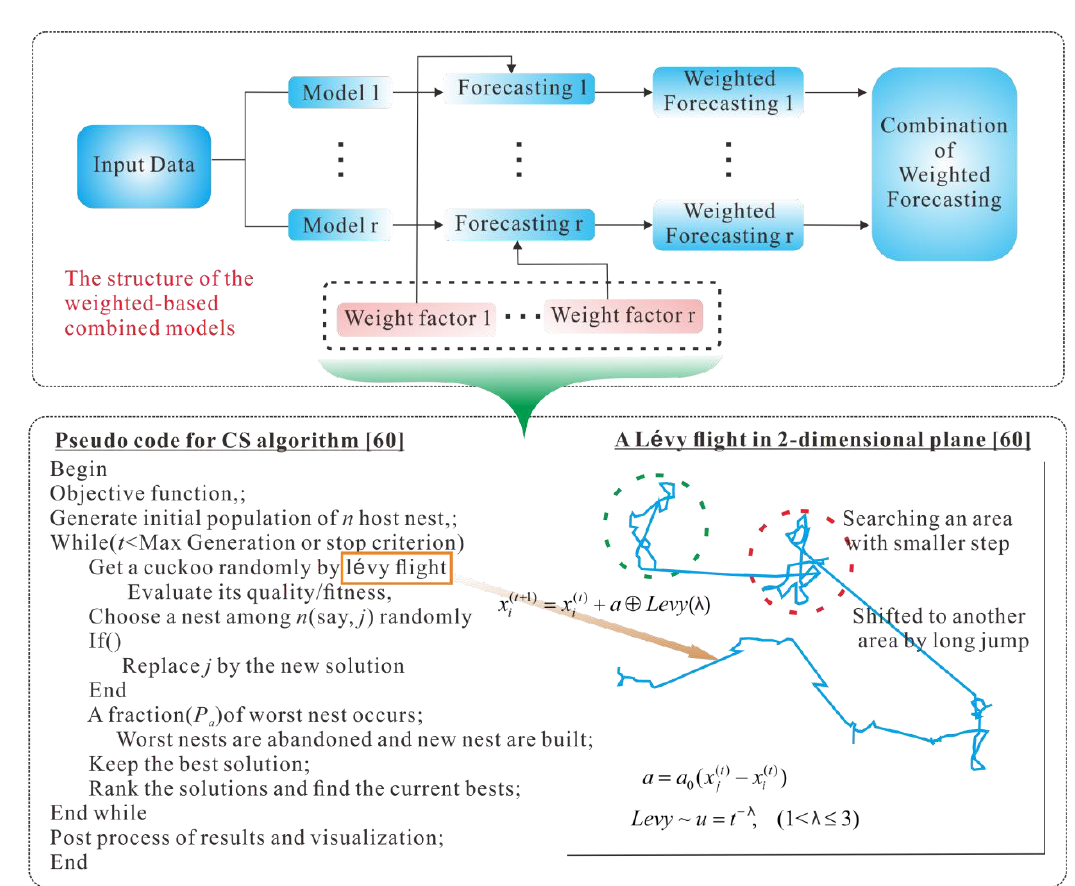
Figure 1. Flowchart of the proposed combined forecasting model based on the cuckoo search algorithm.